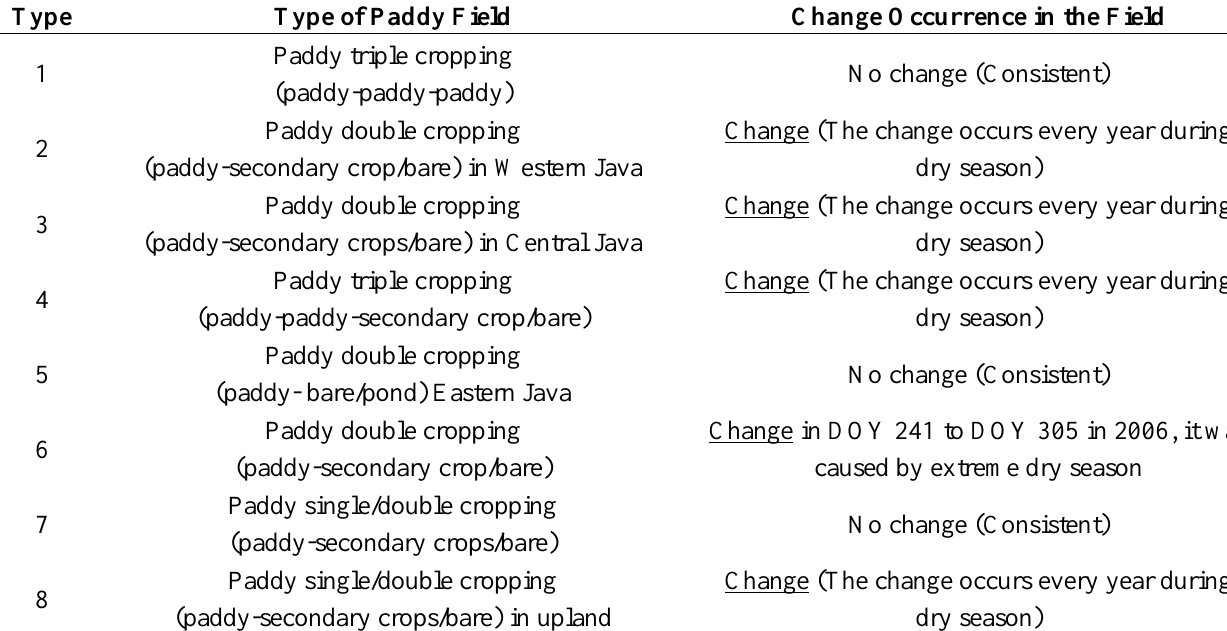
Table 1. A summary of the seasonal change analysis of the eight specific paddy fields.